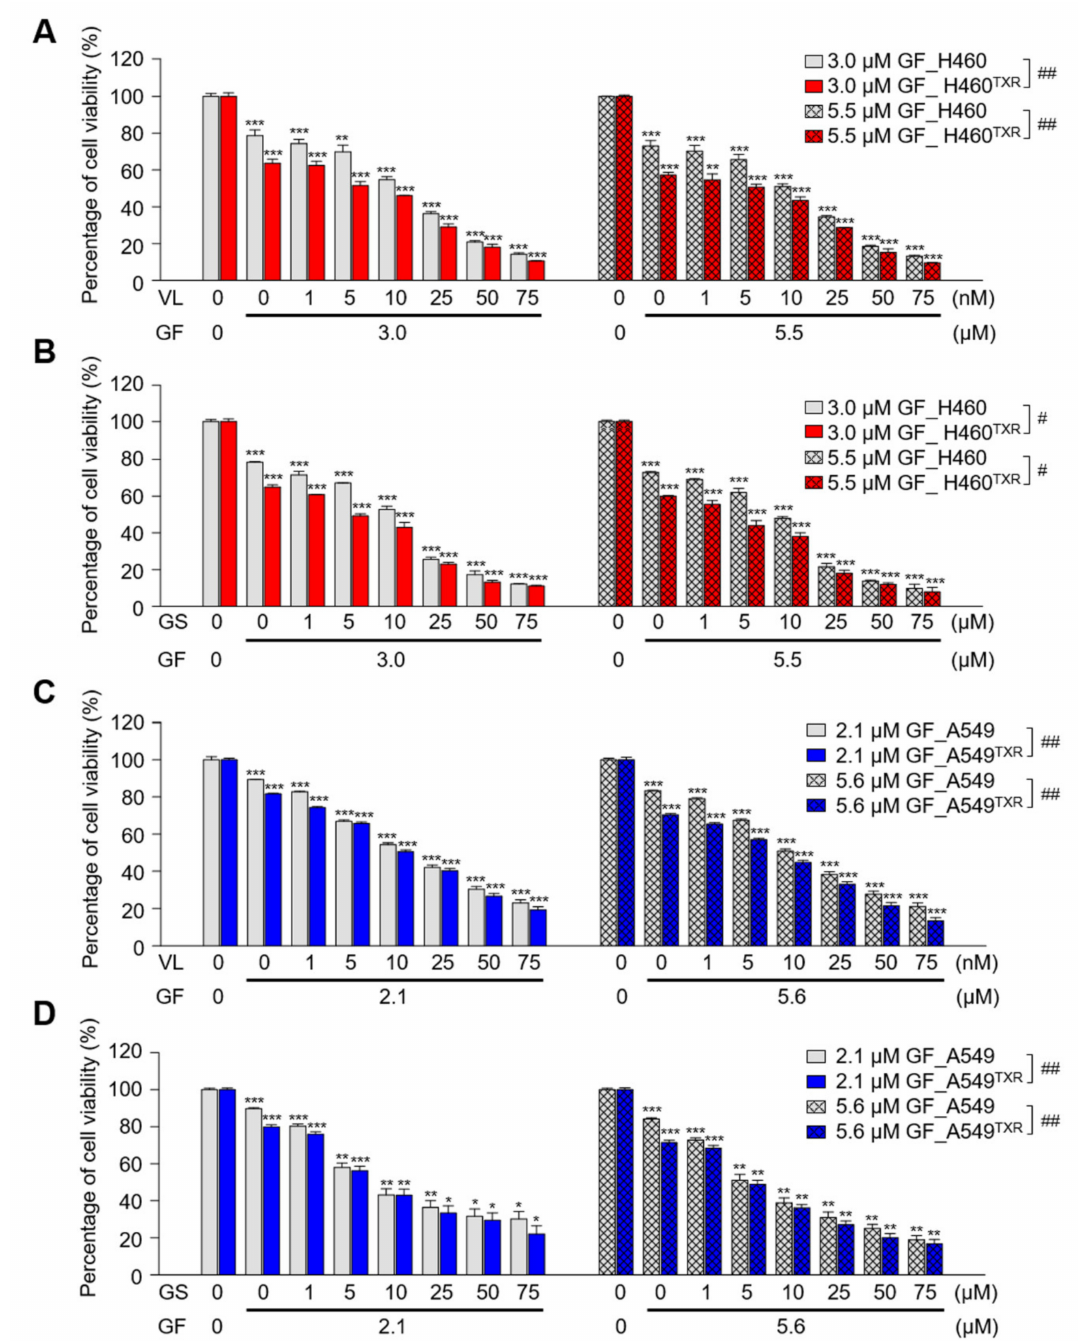
Figure 6. A combination of the EGFR inhibitor gefitinib and PLK1 inhibitor showed strong synergism in paclitaxel-resistant NCI-H460 TXR cells. ( A , B ) A combination between ( A ) gefitinib and ( B ) volasertib or genistein was performed in parental (H460) and paclitaxel-resistant NCI-H460 (H460 TXR ) cells in a concentration-dependent manner for 48 h. The combination of gefitinib and ( C ) volasertib or ( D ) genistein was performed in parental (A549) and paclitaxel-resistant A549 (A549 TXR ) cells in a concentration-dependent manner for 48 h. The percentages of viable cells were measured by a cell viability assay and plotted. Cells were grown for 48 h in the presence of 3.0 or 5.5 µ M gefitinib with volasertib or genistein at the concentrations indicated in the figures. The percentages of viable cells were measured by cell viability assay. Three independent experiments were performed. Values are presented as means ± SEMs (error bars). *, p < 0.05; **, p < 0.01; ***, p < 0.001 compared with vehicle-treated cells. #, p < 0.05; ##, p < 0.01 compared with compared with indicated groups of